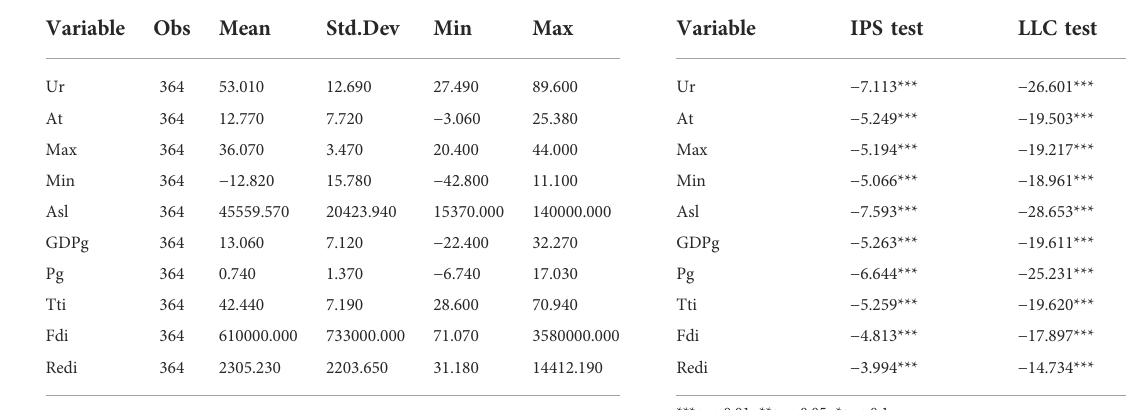
TABLE 2 Descriptive statistics. TABLE 3 Stationarity